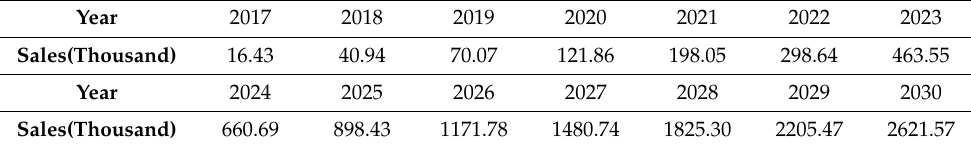
Table 20. The predicted number of EV in South Korea excluding Jeju Island by 2030.